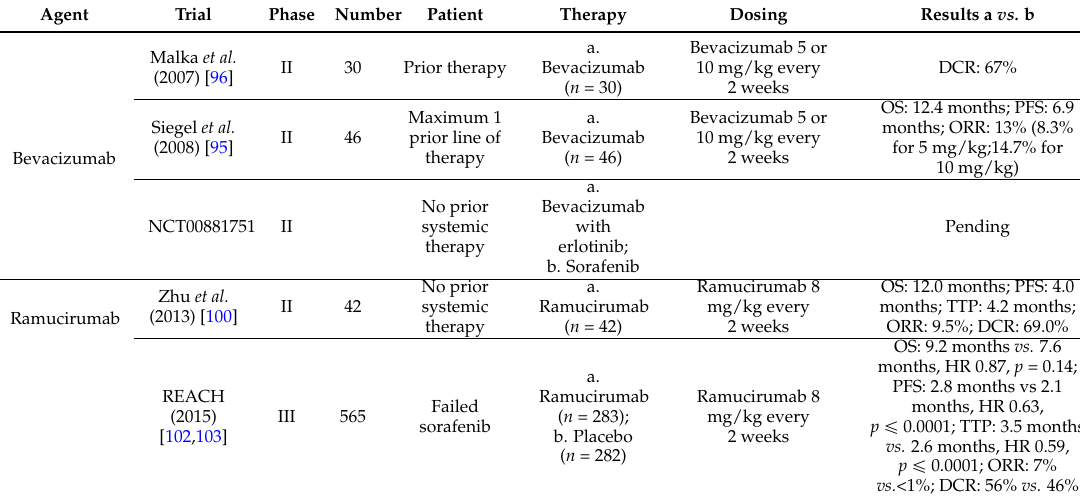
Table 2. Anti-VEGF/VEGFR